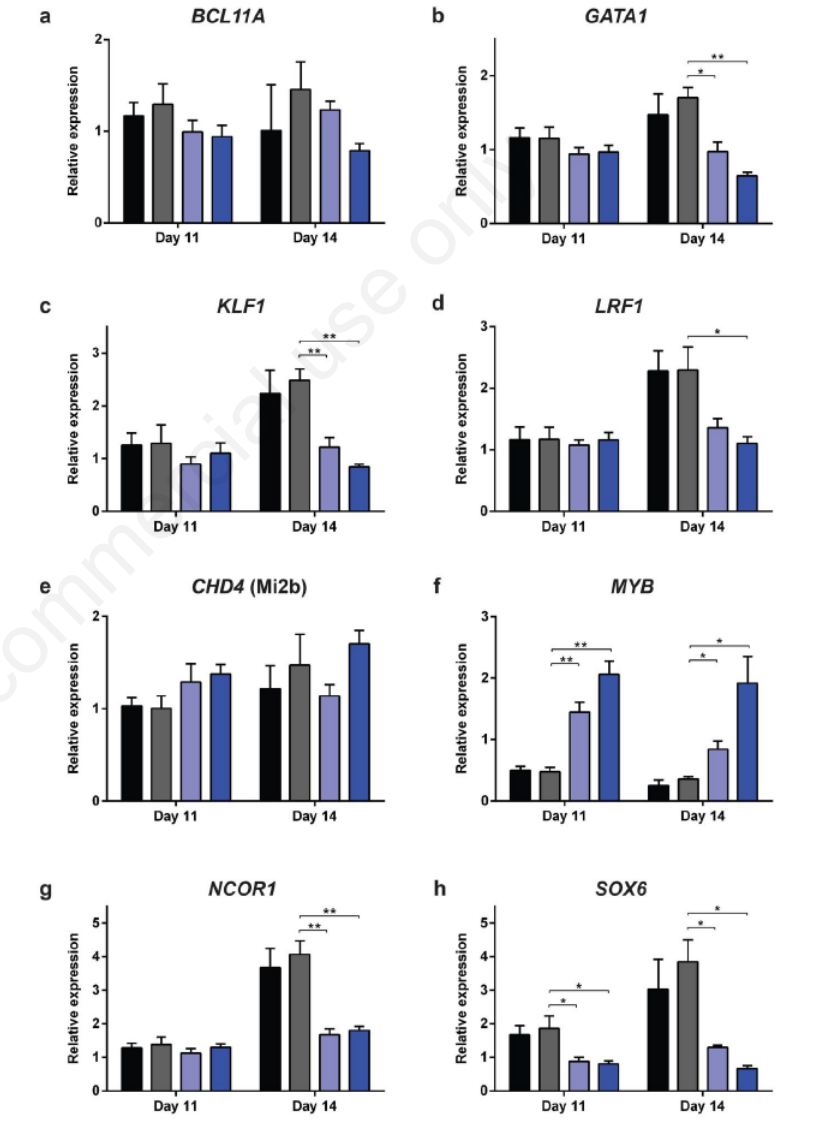
Figure 3. Effect of RN-1 on mRNA expression of fetal hemoglobine (HbF) regulators in 0 -thalassemia/hemoglobine E (HbE) erythroid cells. Relative mRNA abundance of (a) BCL11A, (b) GATA1, (c) KLF1, (d) LRF1, (e) Mi2b, (f) MYB, (g) NCOR1, and (h) SOX6 β normalized to ribosomal protein S18 (RPS18) determined by quantitative real-time PCR in cells days 11 and 14 of culture (3 and 6 days after RN-1 treatment). Data are repre- sented as mean±SEM of relative fold change to DMSO vehicle control (n=4). *P<0.05; **P<0.01. Black bar, untreated control; gray bar, DMSO control; light blue bar, 0.004 uM RN-1 treatment; dark blue bar, 0.02 uM RN-1